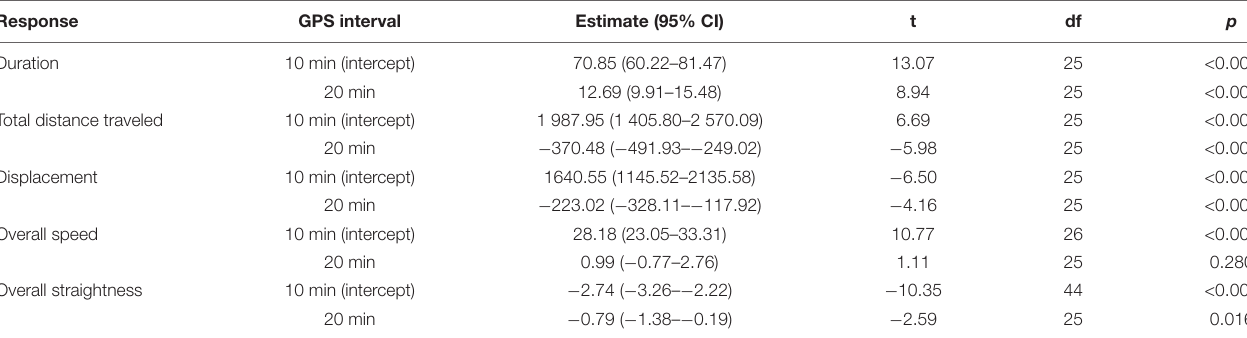
TABLE 5 | Generalized linear mixed models (GLMMs) comparing overall wolf flight responses calculated from GPS data at varying sampling intervals during experimental human approach trials on wild wolves (from flight initiation to resettling).